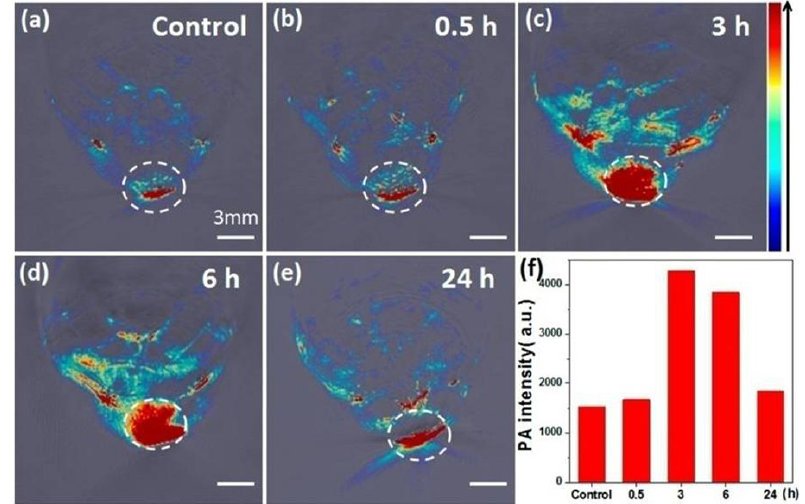
Figure 3. In vivo multispectral optoacoustic tomography (MSOT) imaging. ( a – e ) MSOT images of tumor before and after intravenous injection with Bi 2 S 3 nanorods (NRs); and ( f ) photoacoustic signal intensity in tumor at different time points. Reproduced with permission of [105]. Copyright American Chemical Society, 2015.